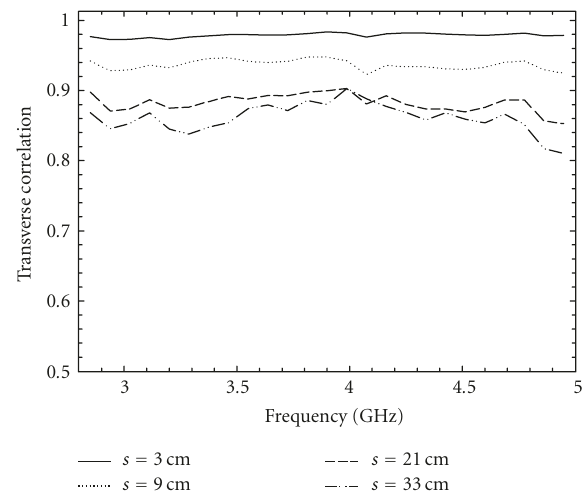
Figure 9: Transverse correlation at 3GHz versus axial distance and for di ff erent spacing in the transverse plane.